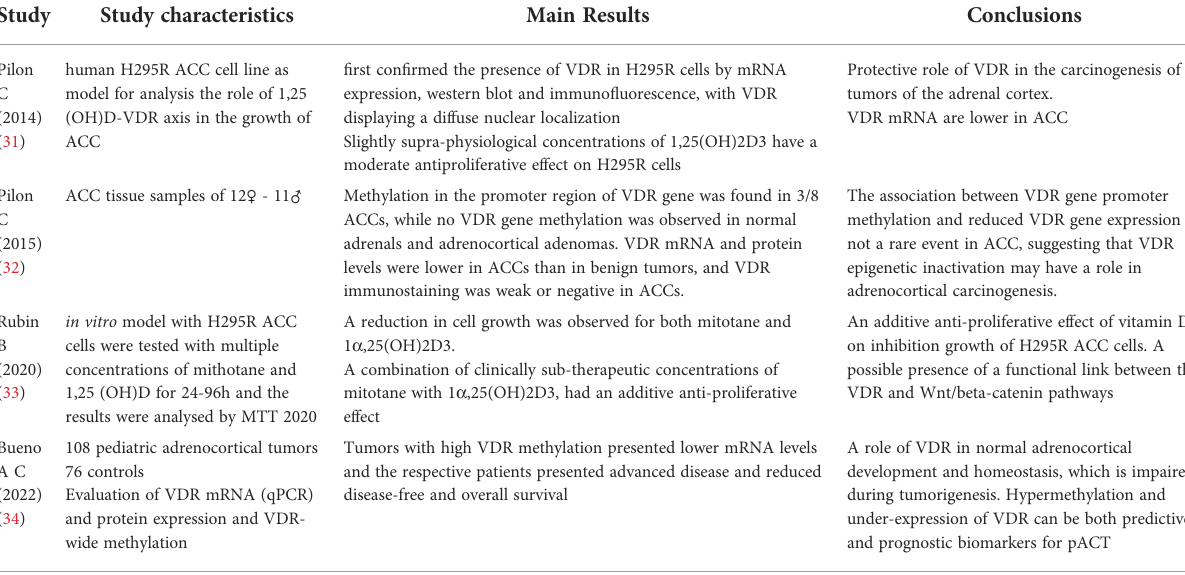
TABLE 2 Main characteristics of the 4 studies included in the review on Adrenal Tumors and Vitamin